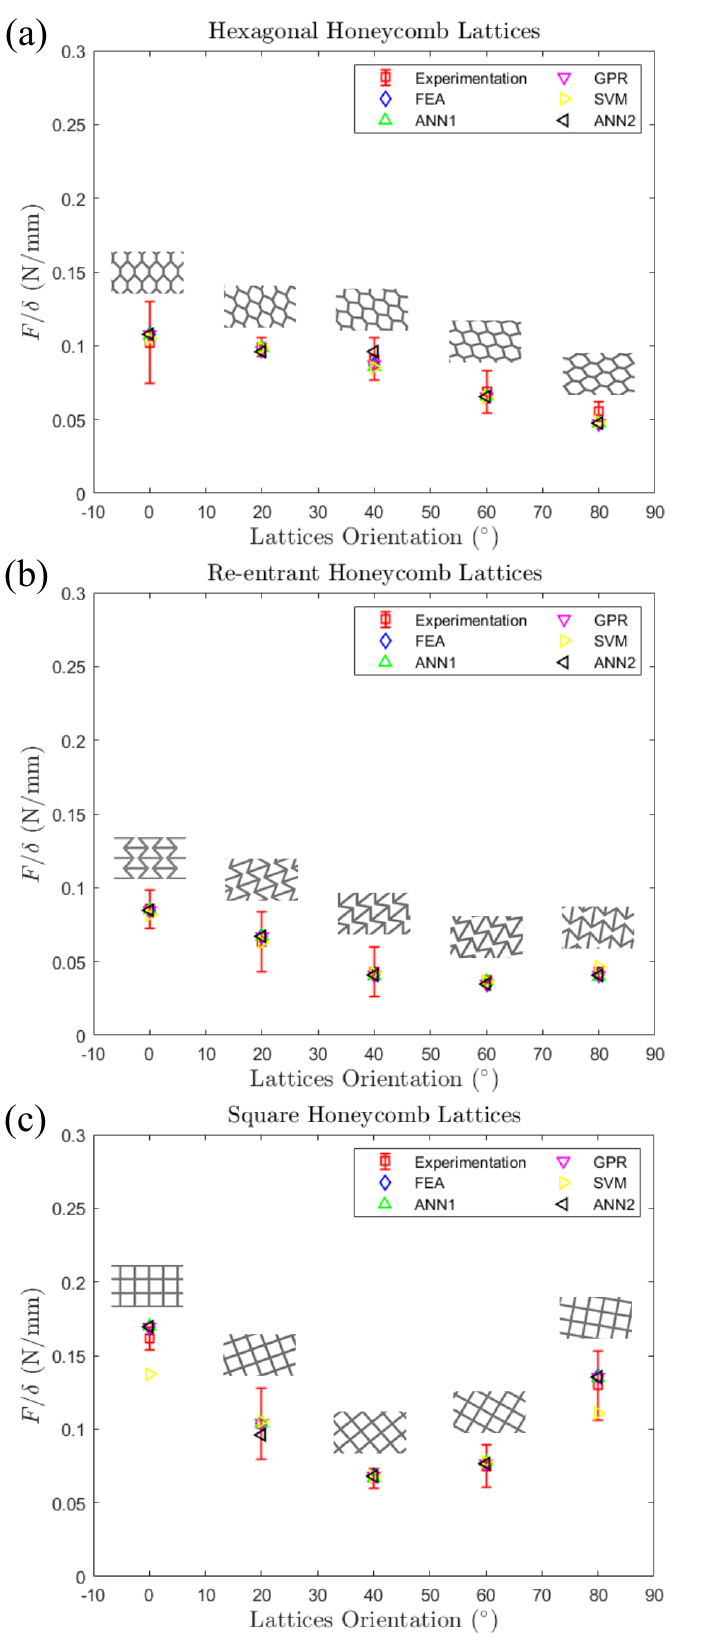
Figure 15. Stiffness as a function of the orientation angle, with data from experimental findings, simulation, and ML predictions. ( a ) Hexagonal lattice-flexure hinges. ( b ) Re-entrant lattice-flexure hinges. ( c ) Square lattice-flexure